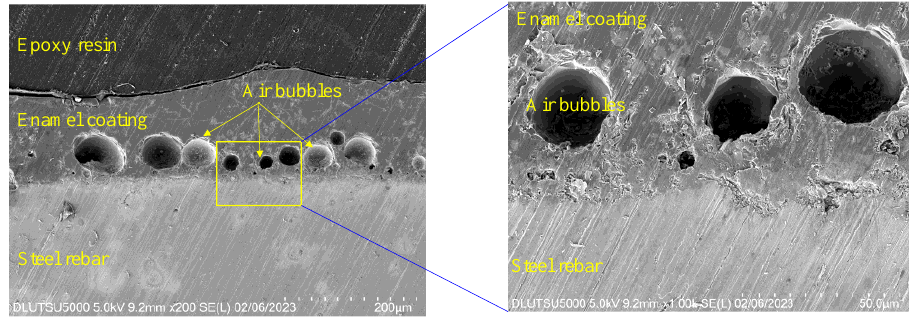
Figure 3. Microstructure of enamel coating.